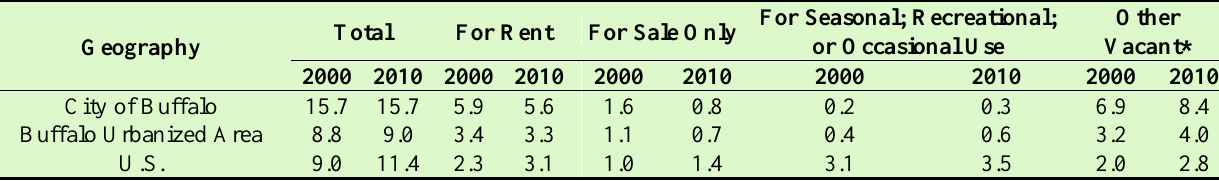
Table 1. Percent of vacant houses in buffalo and in the U.S. Source: US. Census Bureau, 2000, 2010.